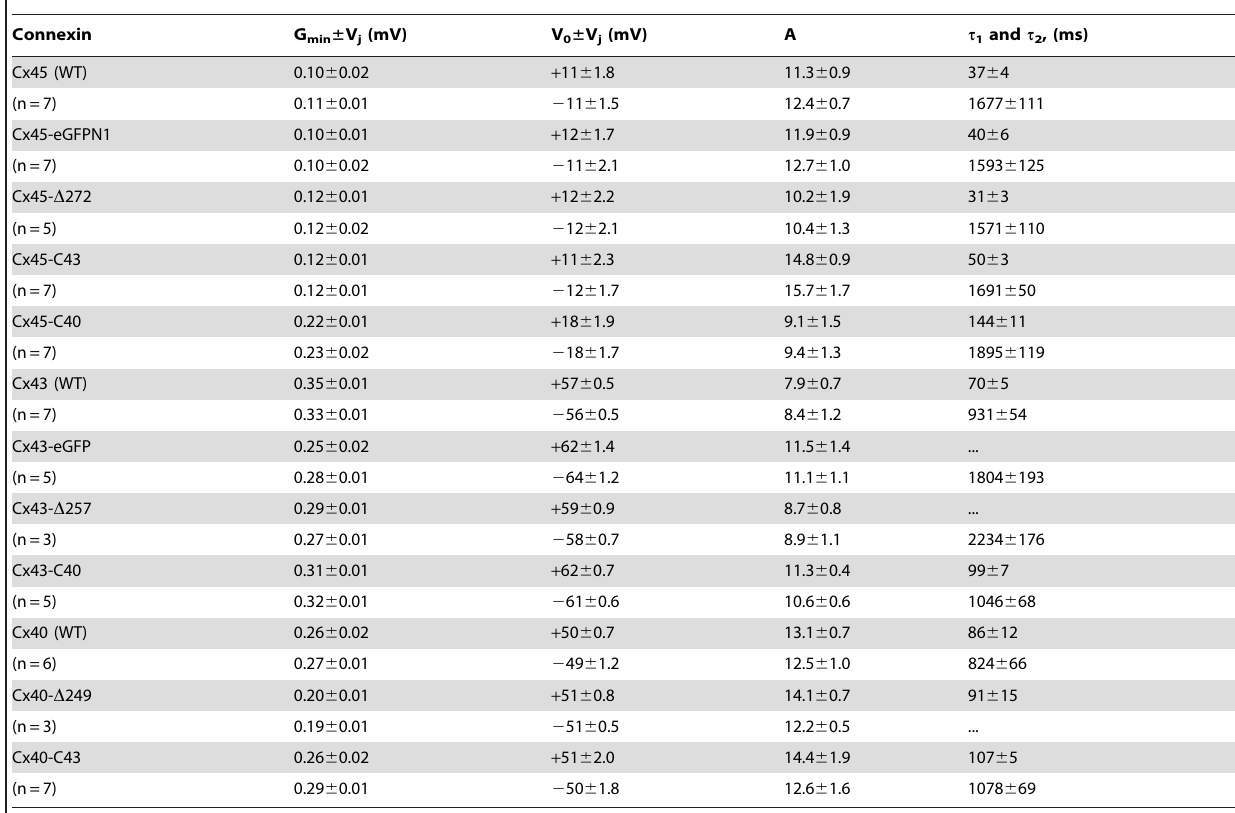
Table 2. Boltzmann fitting parameters for different